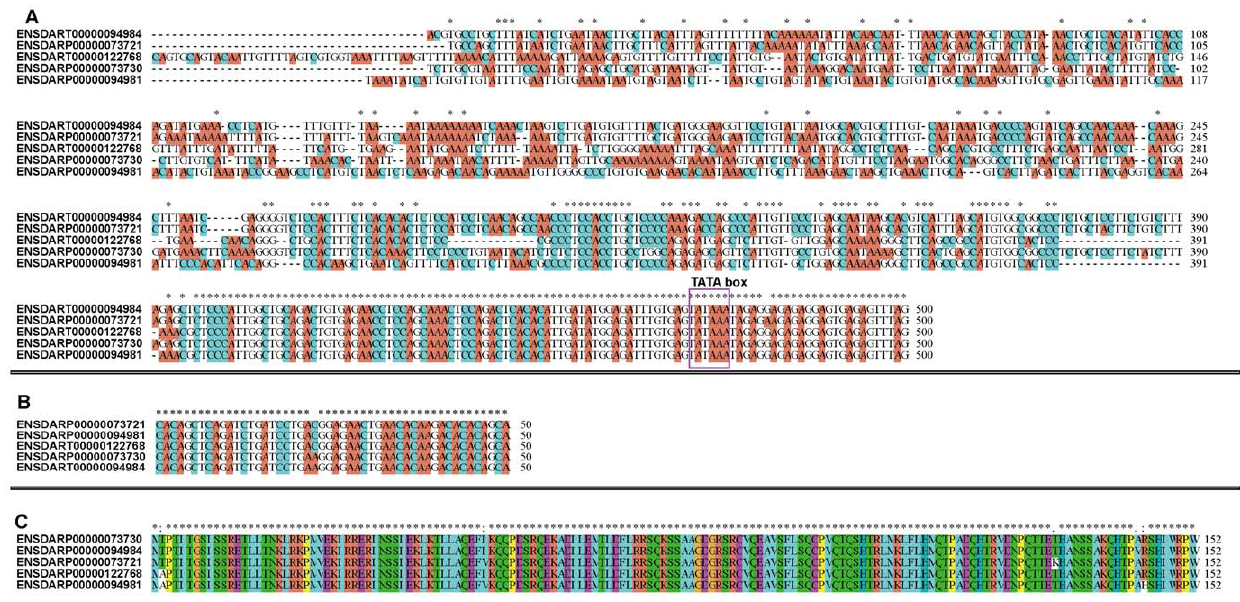
Figure 6. The alignment of the promoter, 5 9 UTR and protein sequences in zebrafish HES5. (A) Multiple sequence alignment of the promoter sequences of zebrafish HES5 genes using the ClustalX2. The TATA box was circled by purple box. (B) Alignment of 5 9 UTR sequence of zebrafish HES5 genes. (C) Alignment of zebrafish HES5 protein sequences.